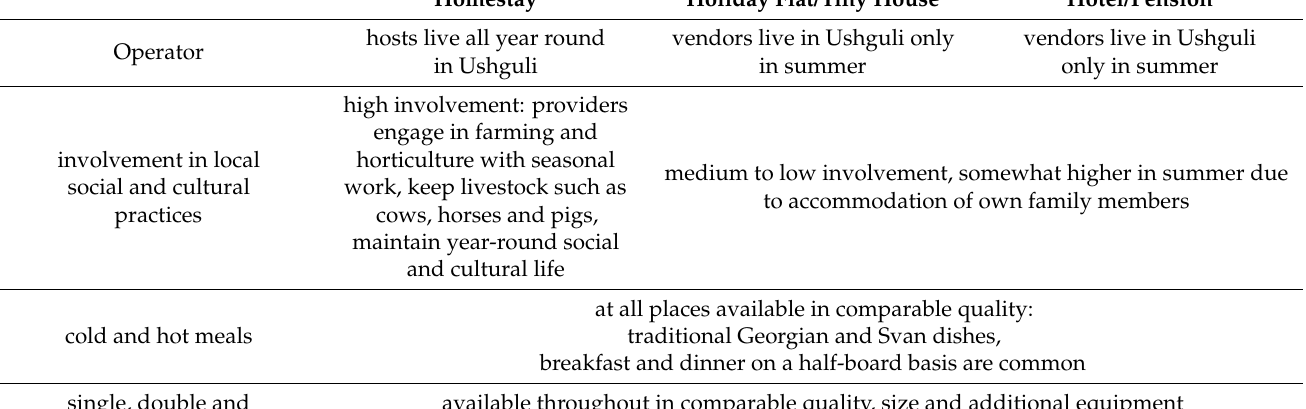
Table 1. Types of accommodation in Ushguli (Svaneti, Georgia). Homestay Holiday Flat/Tiny